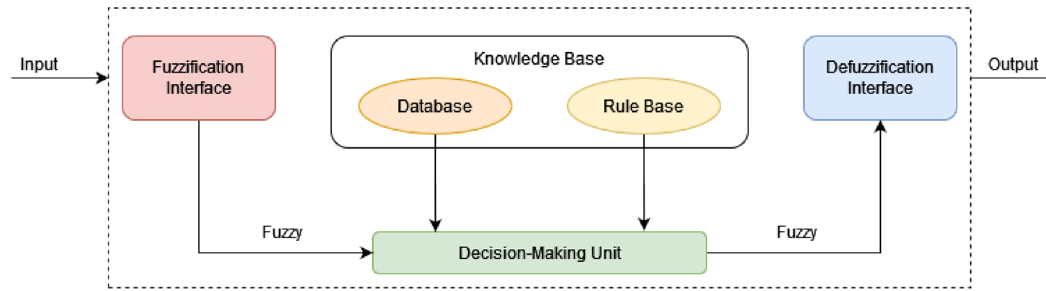
Figure 3. Fuzzy inference structure.